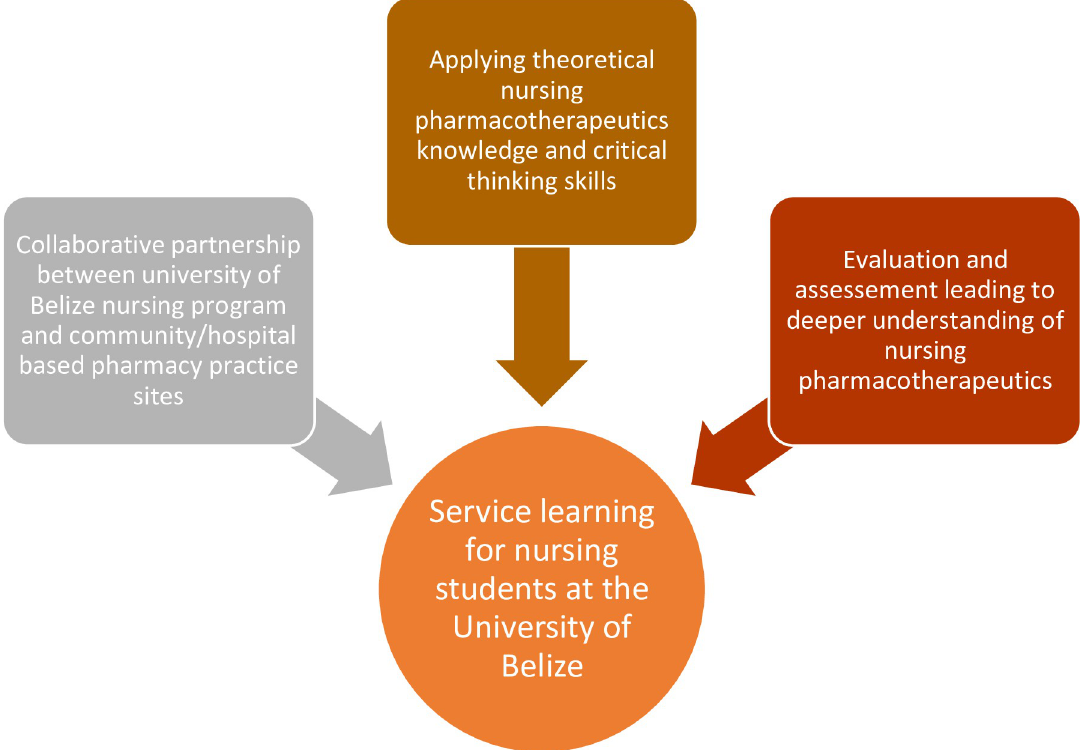
Fig 1. Service-learning